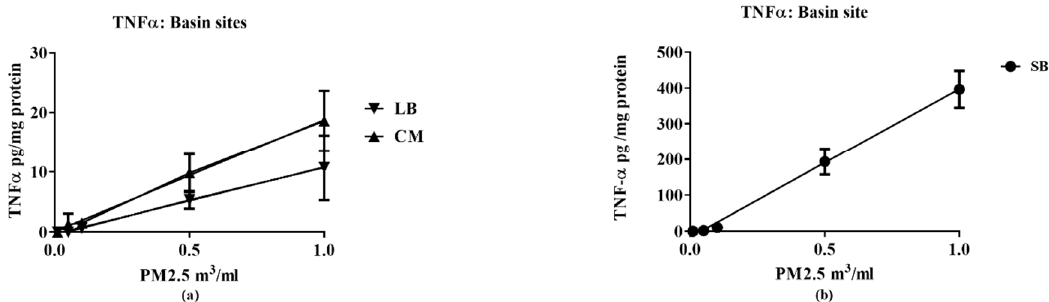
Figure 4. Relative potencies of air samples from CM, LB ( a ) and SB ( b ) to increase TNF- α in RAW 264.7 macrophages. TNF- α expression in the media was measured following exposure to the indicated PM 2.5 concentrations for 16 h. The solid lines represent the best line fit following linear regression analysis of the results (n = 3 for each data point) with potencies indicated by the slopes (values of the regression analysis are detailed in supplemental data—Table S4).